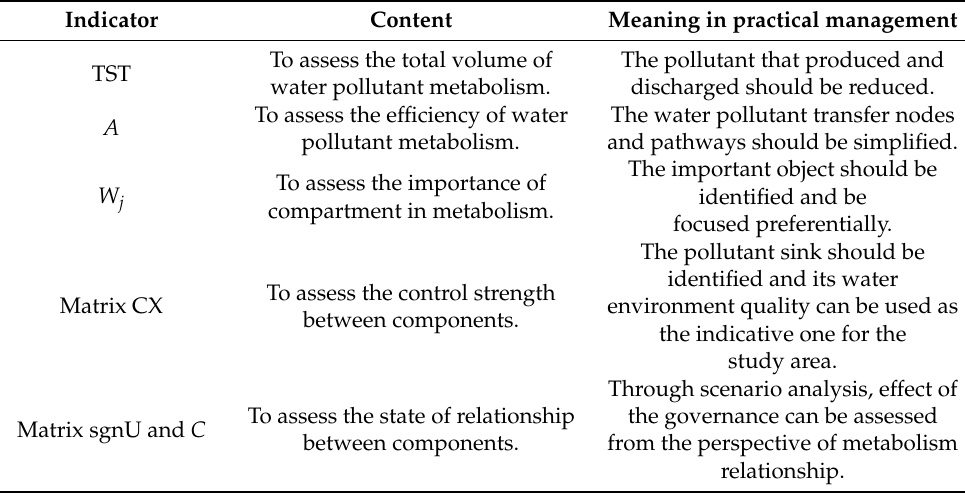
Table 10. ENA indicators for evaluation of water pollutant